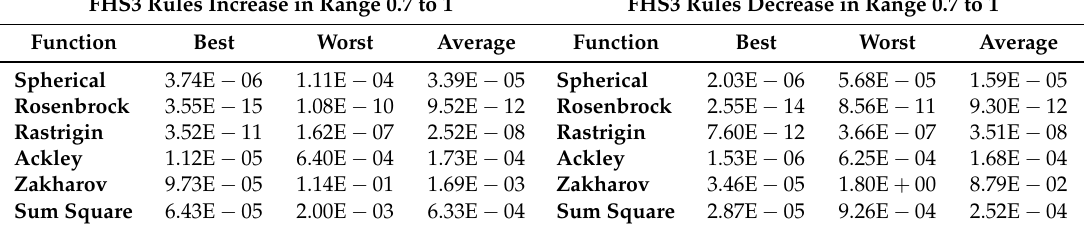
Table 10. Comparison of results obtained with FHS 3 using fuzzy logic rules for increasing and decreasing using the range 0.7 to 1 for the two outputs.